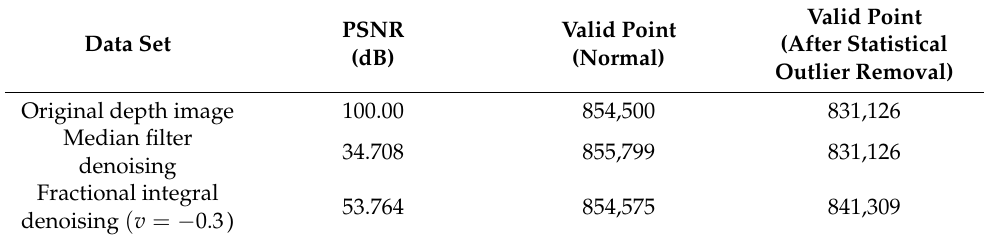
Table 2. Fractional integral denoising operator filtering